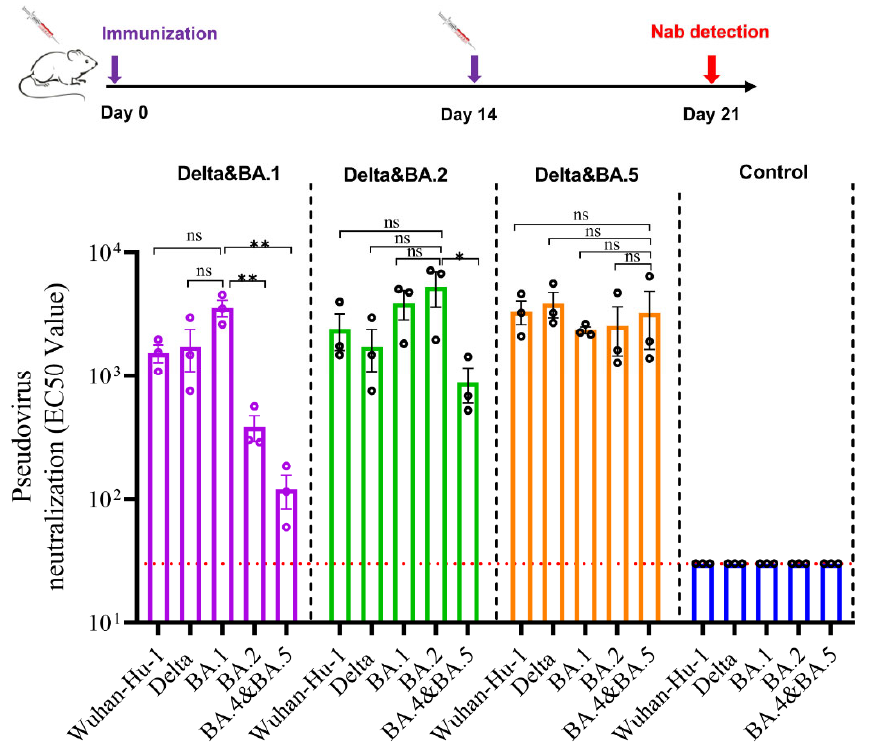
Figure 4. Bivalent vaccine produced high level neutralizing antibodies against the SARS-CoV-2 variants. BALB/c mice were immunized twice with bivalent vaccines (Delta/BA.1, Delta/BA.2, Delta/BA.5) or PBS on day 0 and 14. The VNTs were measured via the pseudovirus neutralization assay on day 21; n = 3. * p < 0.05; ** p < 0.01; ns, no significance.